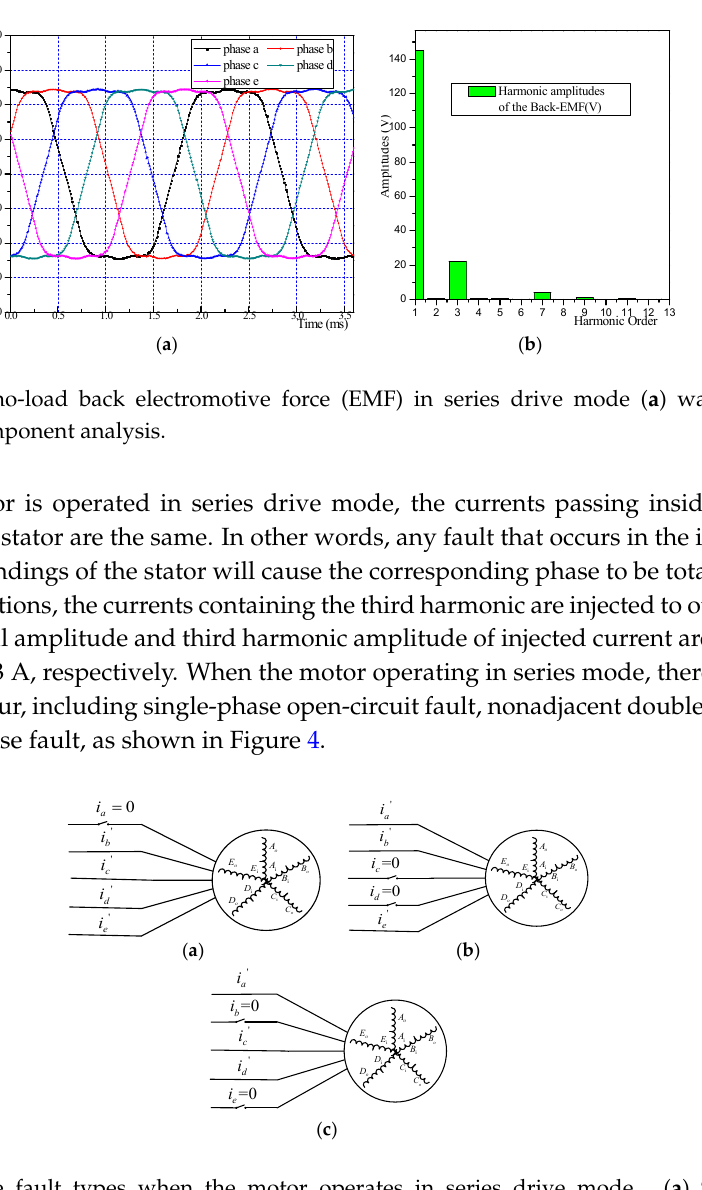
Figure 4. Three fault types when the motor operates in series drive mode. ( a ) Single ‐ phase open ‐ circuit fault; ( b ) adjacent double ‐ phase fault; ( c ) nonadjacent double ‐ phase fault.